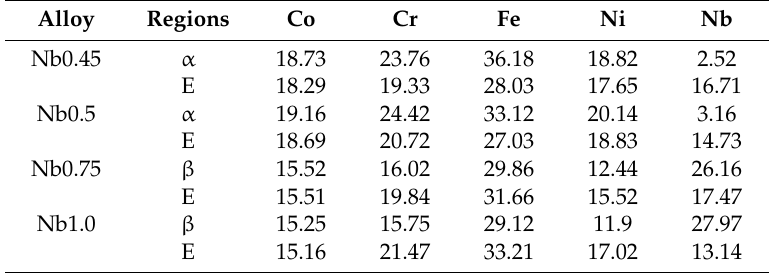
Table 2. Chemical compositions of CoCrFeNiNb x HEA coatings at the various regions (eutectic region is denoted by E) in Figure 3, given as atomic